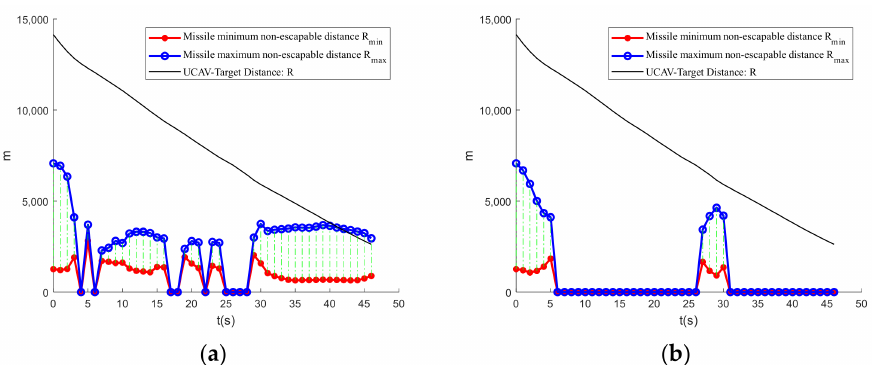
Figure 18. UCAV-enemy relative distance and missile inescapable distance curve. ( a ) UCAV; ( b )